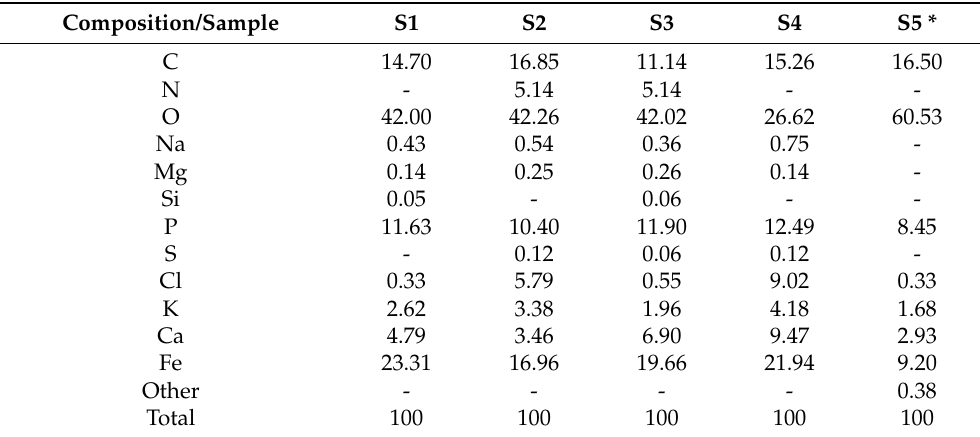
Table 2. Results of the elemental analysis (in mass %) of biogenic ferrihydrite samples S1, S2, S3, S4, and S5 *